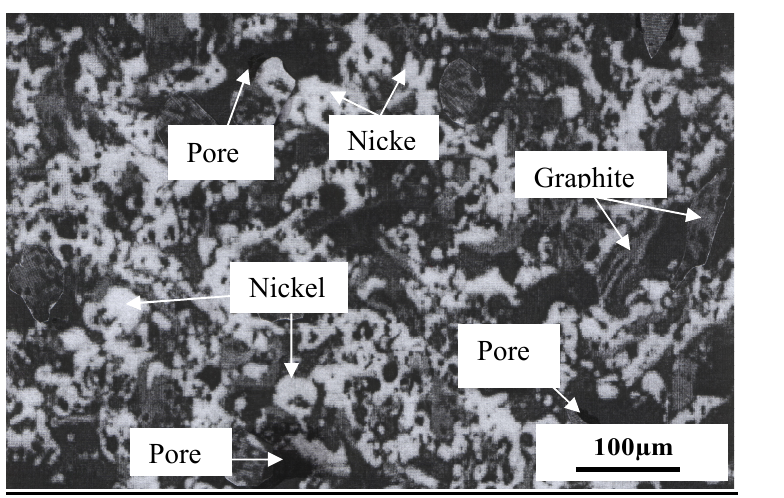
Figure 7 – Microstructure of Ni-15% graphite layers deposited with 700A Slika 7 – Mikrostruktura Ni-15% grafit slojeva deponovanih sa